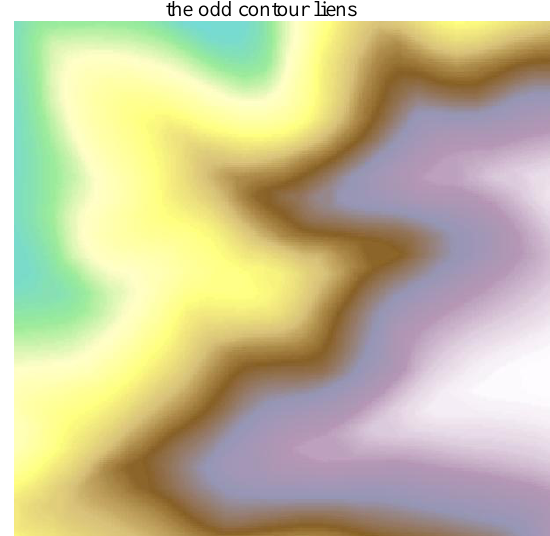
(f) The interpolated DEM by our method